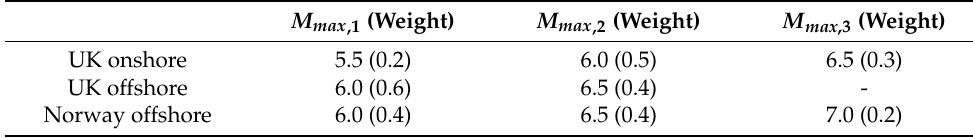
Table 2. Maximum magnitude model for